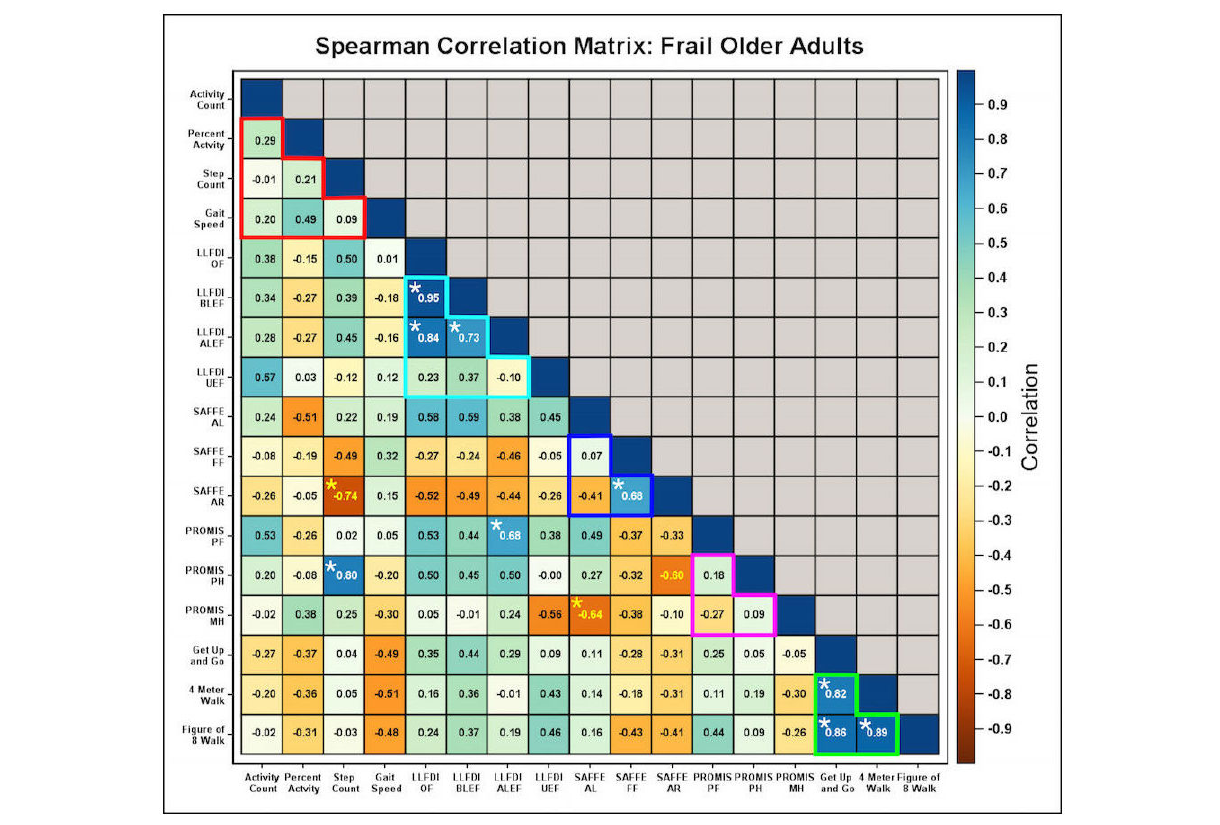
Figure 7. Fewer significant correlations across different functional assessment metrics are present in functionally impaired older adults. Confusion matrix depicting correlation structure of mobile phone-based activity measures, questionnaire-based measures of functional status, and performance battery based measures of functional status for frail participants. Layout similar to Figure